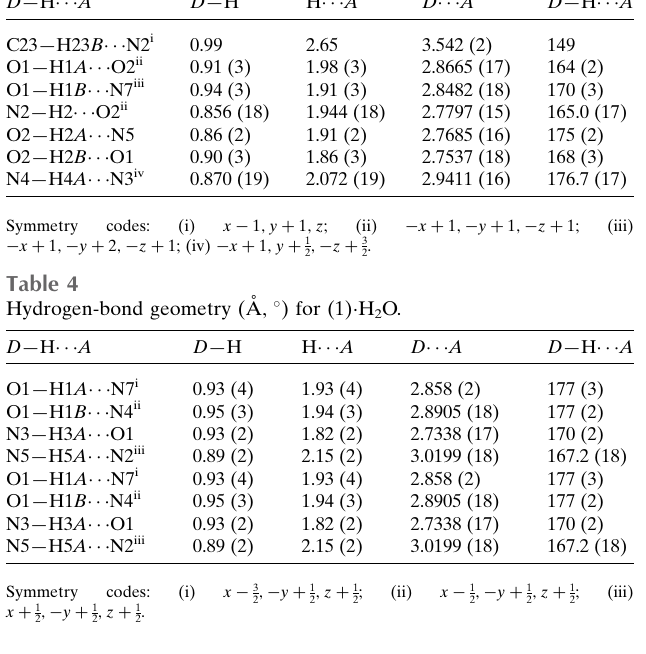
(Fig. 4 and Table 3), the remaining O—H hydrogens form O—